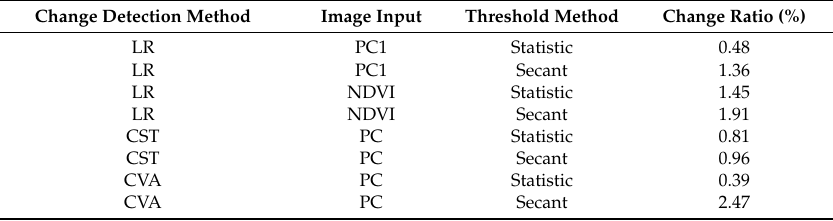
Figure 12. Individual landslide maps obtained by ( a ) LR-PC1-Statistics, ( b ) LR-PC1-Secant, ( c ) LR-NDVI-Statistic, ( d ) LR-NDVI-Secant, ( e ) CST-PC-Statistic, ( f ) CST-PC -Secant, ( g ) CVA-PC-Statistic, and ( h ) CVA-PC-Secant. Table 2. Change ratio resulting from the landslide